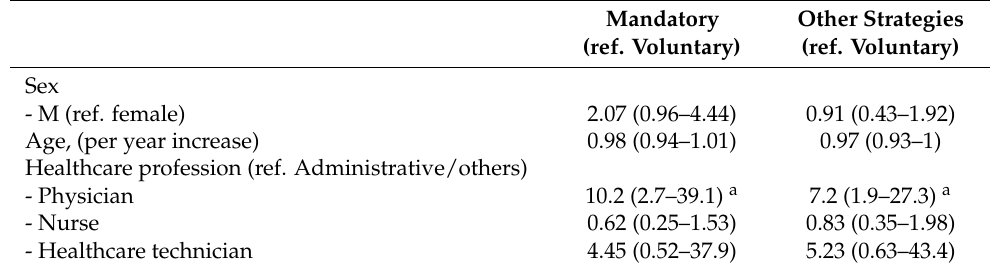
Table 4. Preferred vaccination strategy for healthcare workers (reference